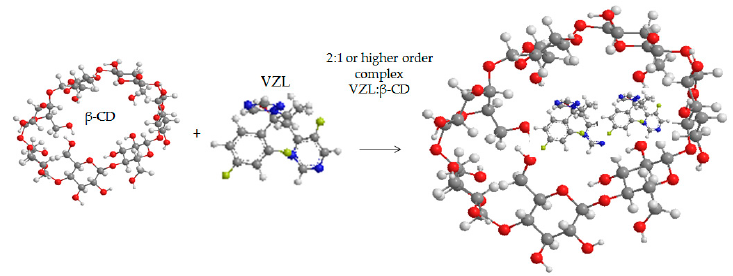
Figure 6. Complexation between VRCZ drug and β -CD.